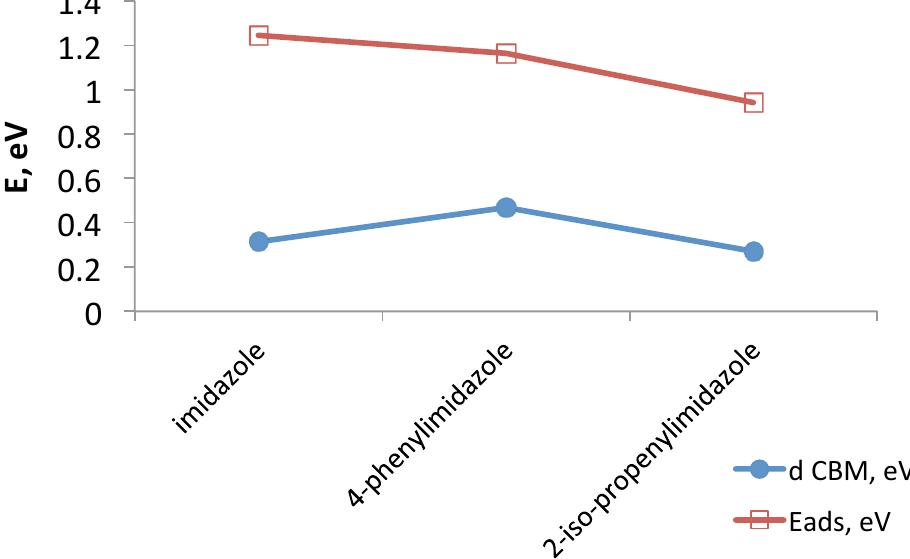
Figure 5 . The co-adsorbent’s adsorption energy (Eads) and the change in the energy of the functionalized TiO conduction band minimum (d CBM) for three imidazole derivatives 2 adsorbed on the anatase (101) surface of TiO , as shown in Figure 2